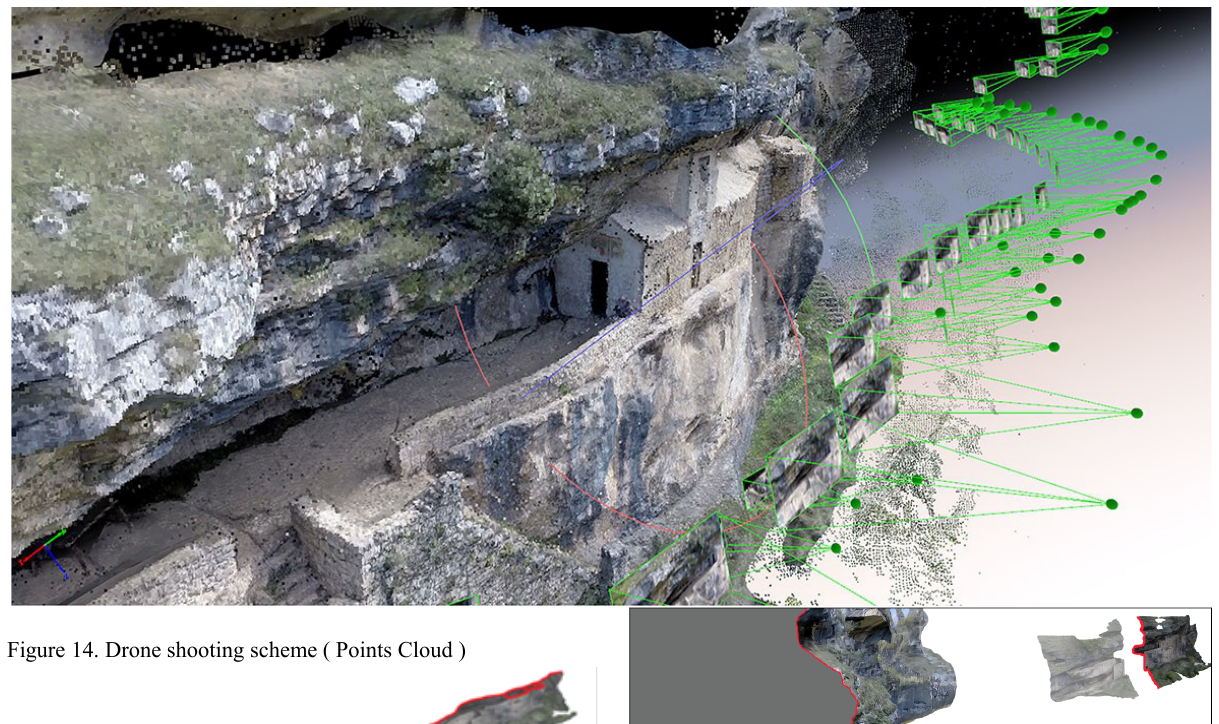
Figure 14. Drone shooting scheme ( Points Cloud )